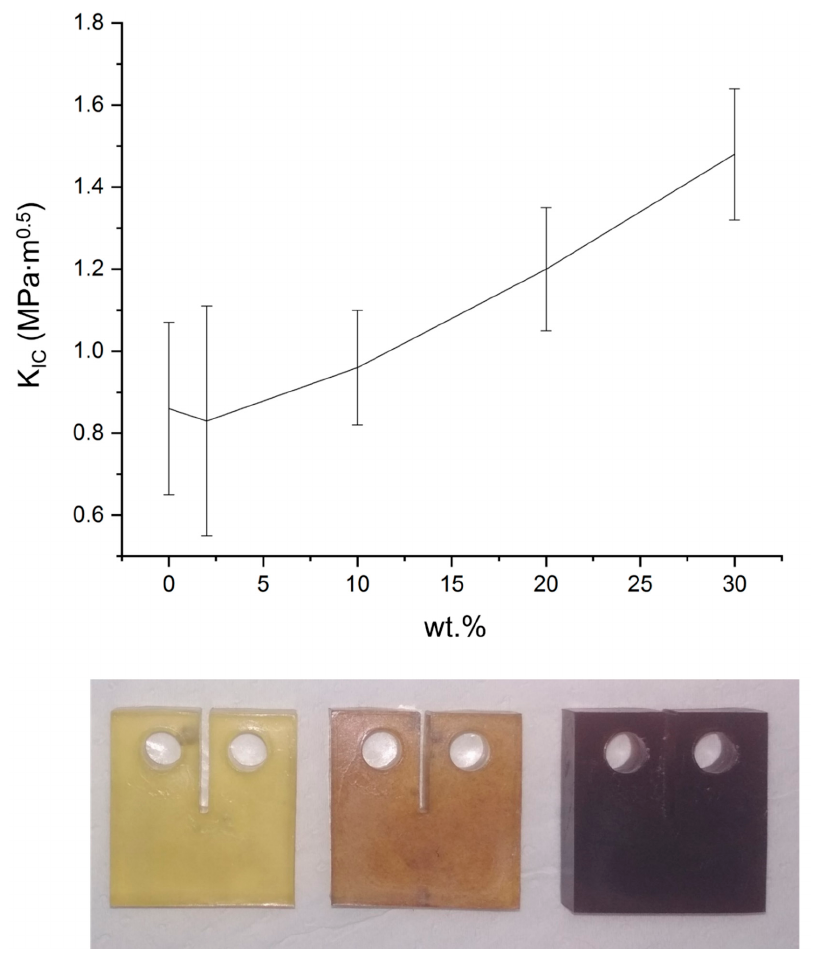
Figure 8. Fracture toughness ( K IC ) of epoxy composites reinforced by glass fibers as a function of weight fraction. Bottom: the change in composites color upon addition of MGF for weight fraction of (from left) 0%, 2% and 10%. No magnetic field was applied, and the fibers were uniformly distributed and randomly oriented.